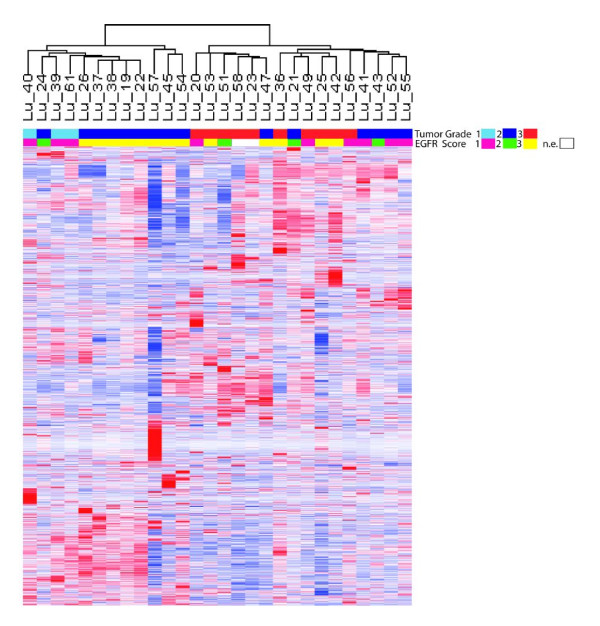
Hierarchical cluster analysis identifies tumor grade as dominant substructure. Hierarchical clustering of 2777 features selected by variation filter shows that the dominant substructure of the dataset is driven by tumor grade and not by EGFR status. All grade 3 tumors were segregated in one major branch. No correlation of EGFR status and the results of hierarchical clustering could be obtained. The upper bar shows the histopathological tumor grade (turquoise = grade 1, blue = grade 2 and red = grade 3). The second bar shows the EGFR expression on protein level (pink = no protein expression, green = incomplete membranous stain and yellow = complete membranous stain). The expression values are indicated by color code (blue = no gene expression and red = high gene expression).